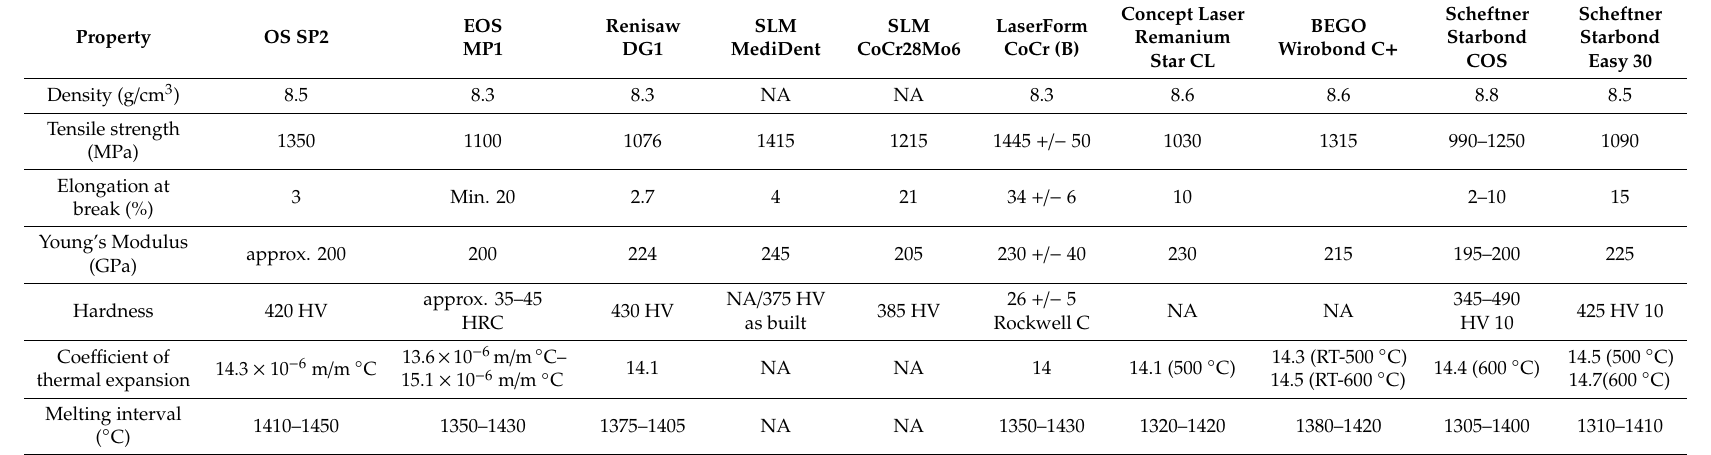
Table 3. Physical and mechanical properties of 3D printed CoCr (after stress relief) provided by their manufacturers after heat treatment. NA: Not available. Data from Reference